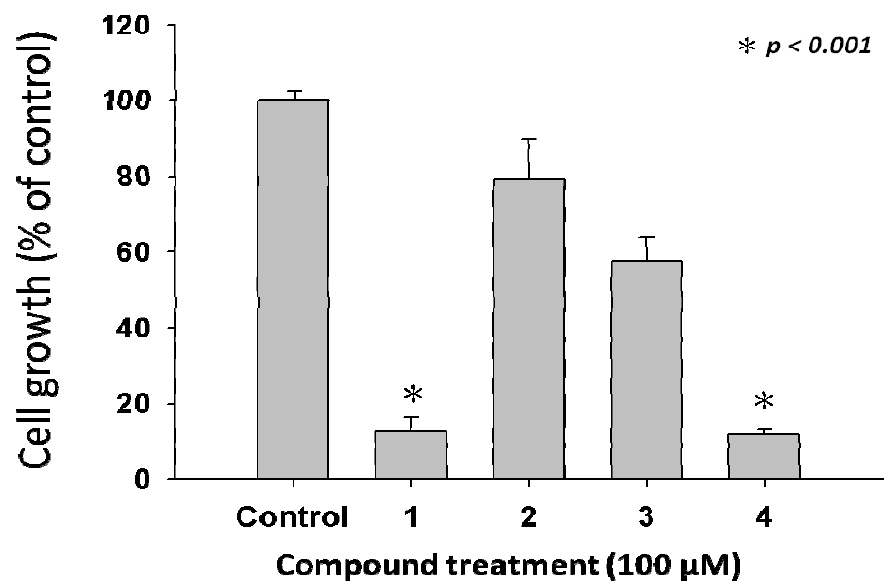
Figure 2. Anti-proliferative effects of L. tulipifera compounds on A375.S2 cells. Cell growth was determined by MTT assay after incubation with 100 μ M of compounds 1 – 4 respectively. Results are expressed as the percent of the cell proliferation of the vehicle control at 24